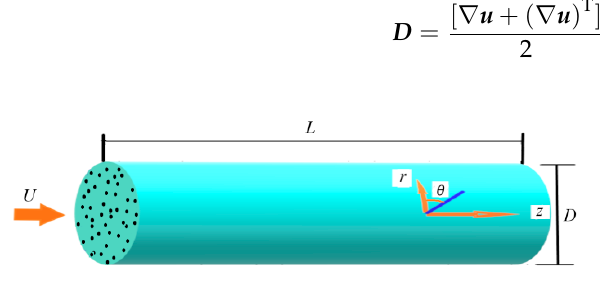
Figure 1. Flow in a pipe and cylindrical coordinate system.